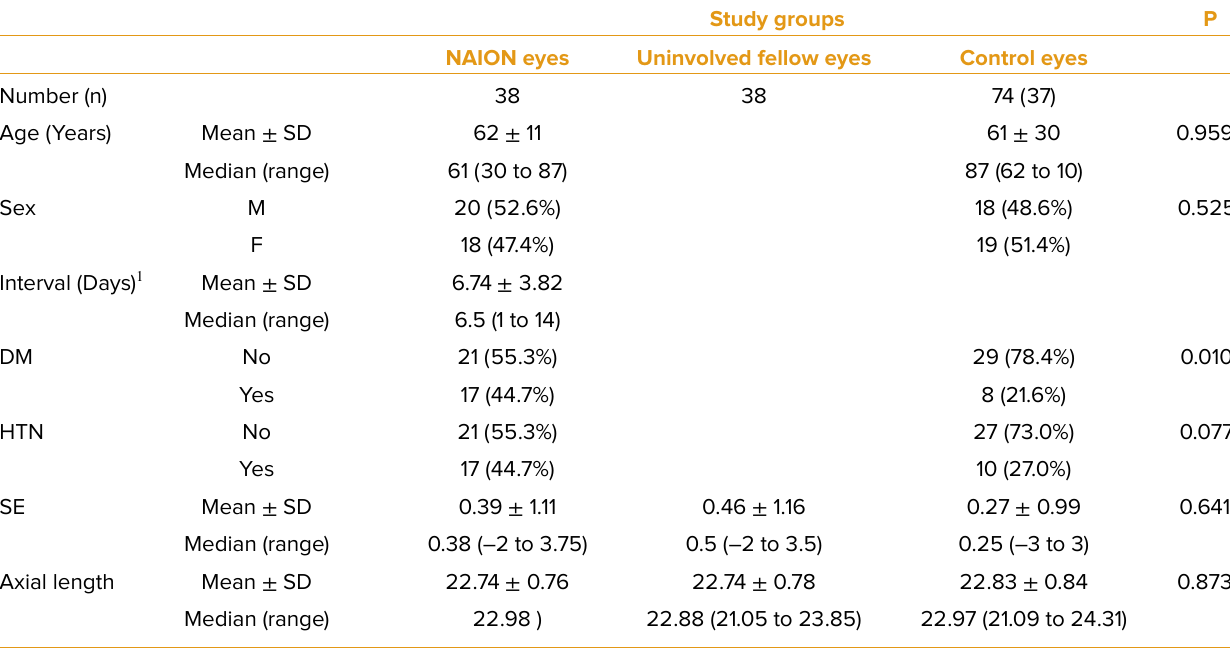
Table 1. Demographic data of NAION patients and healthy control subjects